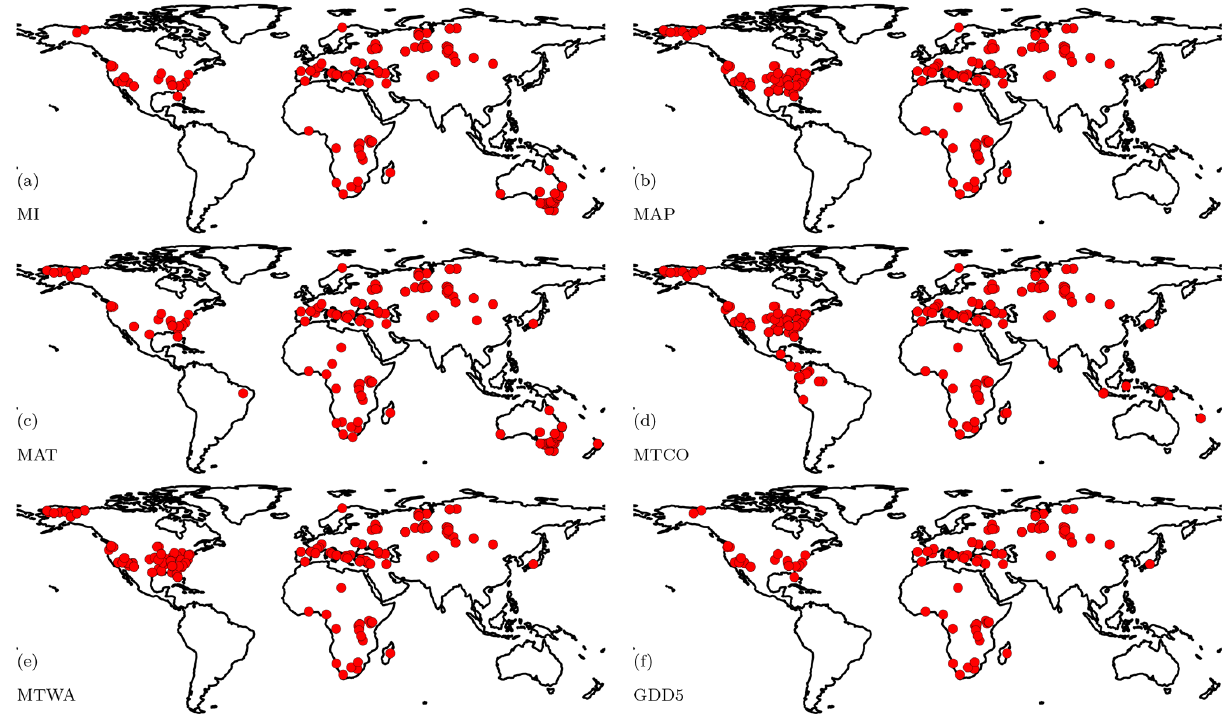
Figure 1. The distribution of the site-based reconstructions of climatic variables at the Last Glacial Maximum. The individual plots show sites providing reconstructions of (a) moisture index (MI), (b) mean annual precipitation (MAP), (c) mean annual temperature (MAT), (d) mean temperature of the coldest month (MTCO), (e) mean temperature of the warmest month (MTWA), and (f) growing degree days above a baseline of 5 ◦ C (GDD5). The original reconstructions are from Bartlein et al. (2011) and Prentice et al. (2017). Table 1. Details of the models from the third phase of the Palaeoclimate Modelling Intercomparison Project (PMIP3) that were used for the Last Glacial Maximum (LGM) simulations used to create the prior. Coupled ocean–atmosphere models are indicated as OA; the OAC models have a fully interactive carbon cycle. The resolution in the atmospheric, oceanic, and sea ice components of the models is given in terms of numbers of grid cells in latitude and